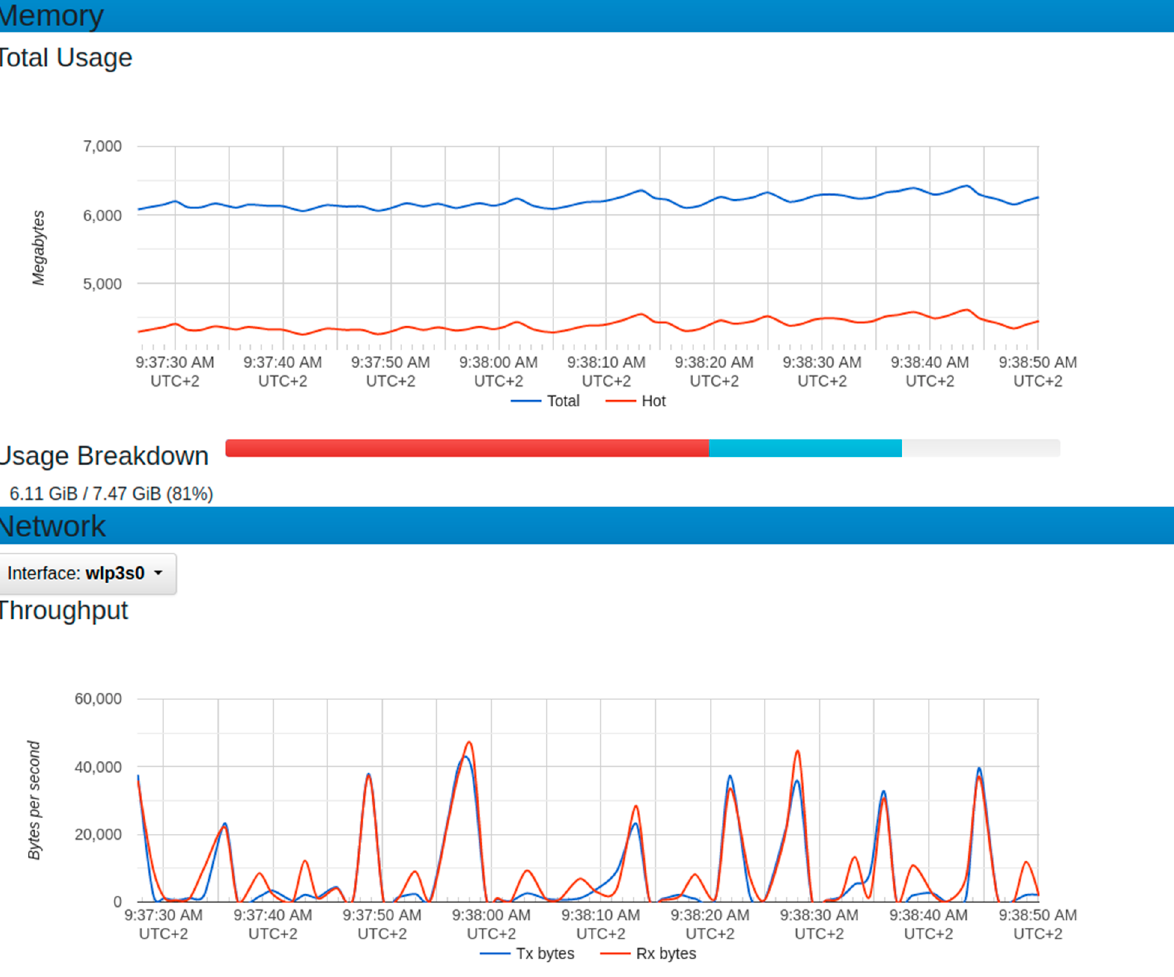
Figure 14. Resource usage for memory and throughput with normal sensor node setup.